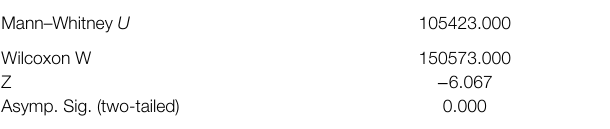
TABLE 8 | The Mann–Whitney U -test statistics of the behavior and pedagogy- related emotional scaffolding strategies. Mann–Whitney U